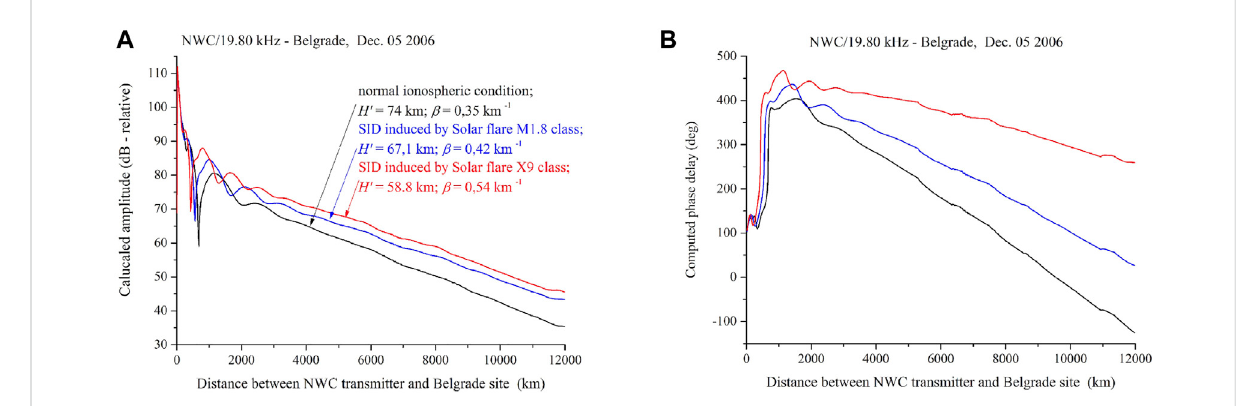
FIGURE 12 The amplitude (A) and phase (B) of the NWC/19.80 kHz radio signal along the GCP distance from Western Australia to Belgrade, calculated for normal and disturbed ionospheric conditions on 05 December